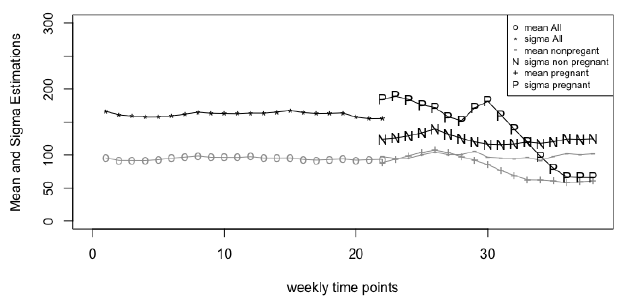
Figure 4. Change of parameter estimates ˆ µ , ˆ σ over 38 weeks.